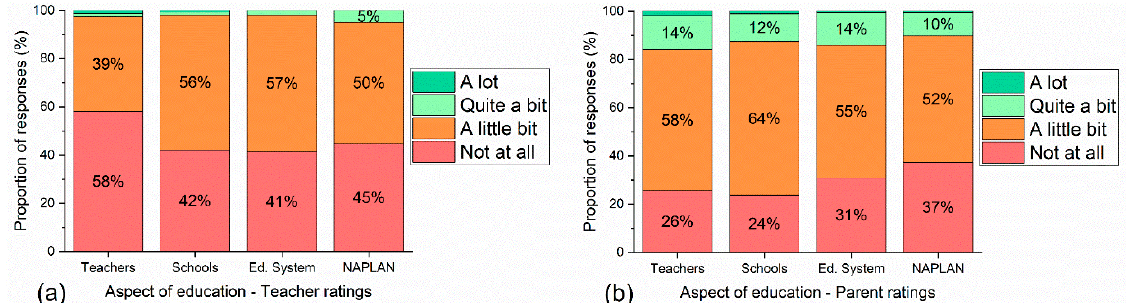
Figure 3. The extent of trust in media reporting of different aspects of education for ( a ) teachers and ( b ) parents. Please note that the labels for percentages lower than 3% are omitted from the charts.